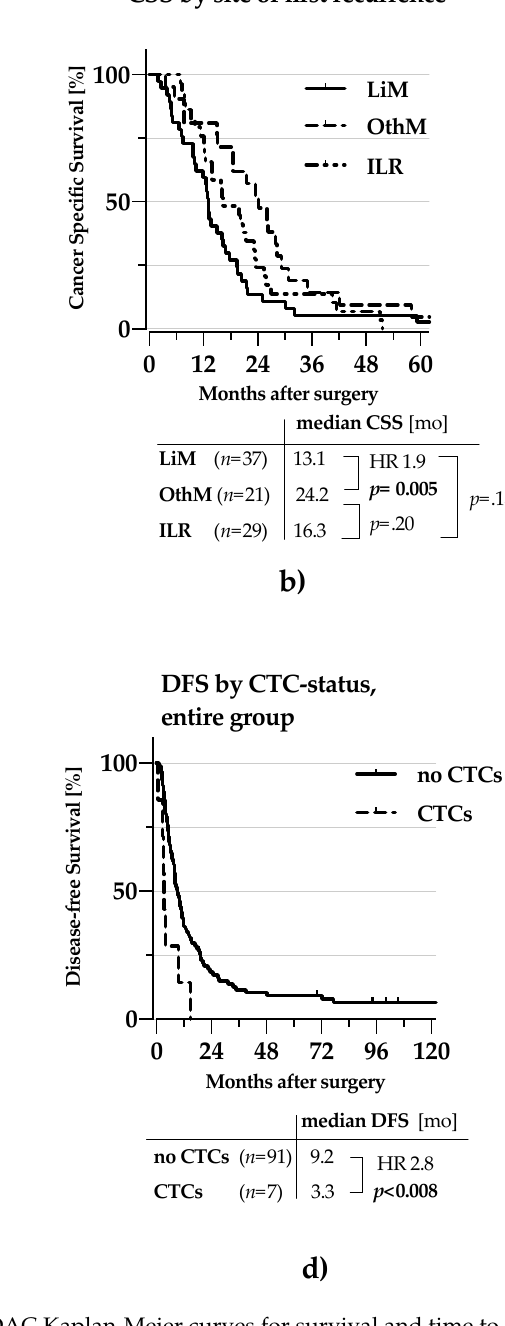
Figure 3. Recurrence and Survival patterns for resected PDAC Kaplan-Meier curves for survival and time to recurrence. ( a ) Incidence by site of first recurrence ( b ) Cancer specific survival by site of first recurrence. ( c ) CSS by CTC-status for all patients ( d ) DFS by CTC-status for all patients, CSS: cancer-specific survival, DFS: disease-free survival, DM: distant metastasis ILR: islolated local recurrence, LiM: Liver metastasis, alone or in combination with others, OthM: any other type of distant metastasis. HR: Hazard ratio. Statistical significance assumed for p < 0.05, indicated by use of bold font. Uni- and multivariable analysis of risk-factors for either TDM, TILR or CSS identified several independent risk factors (Table 2).